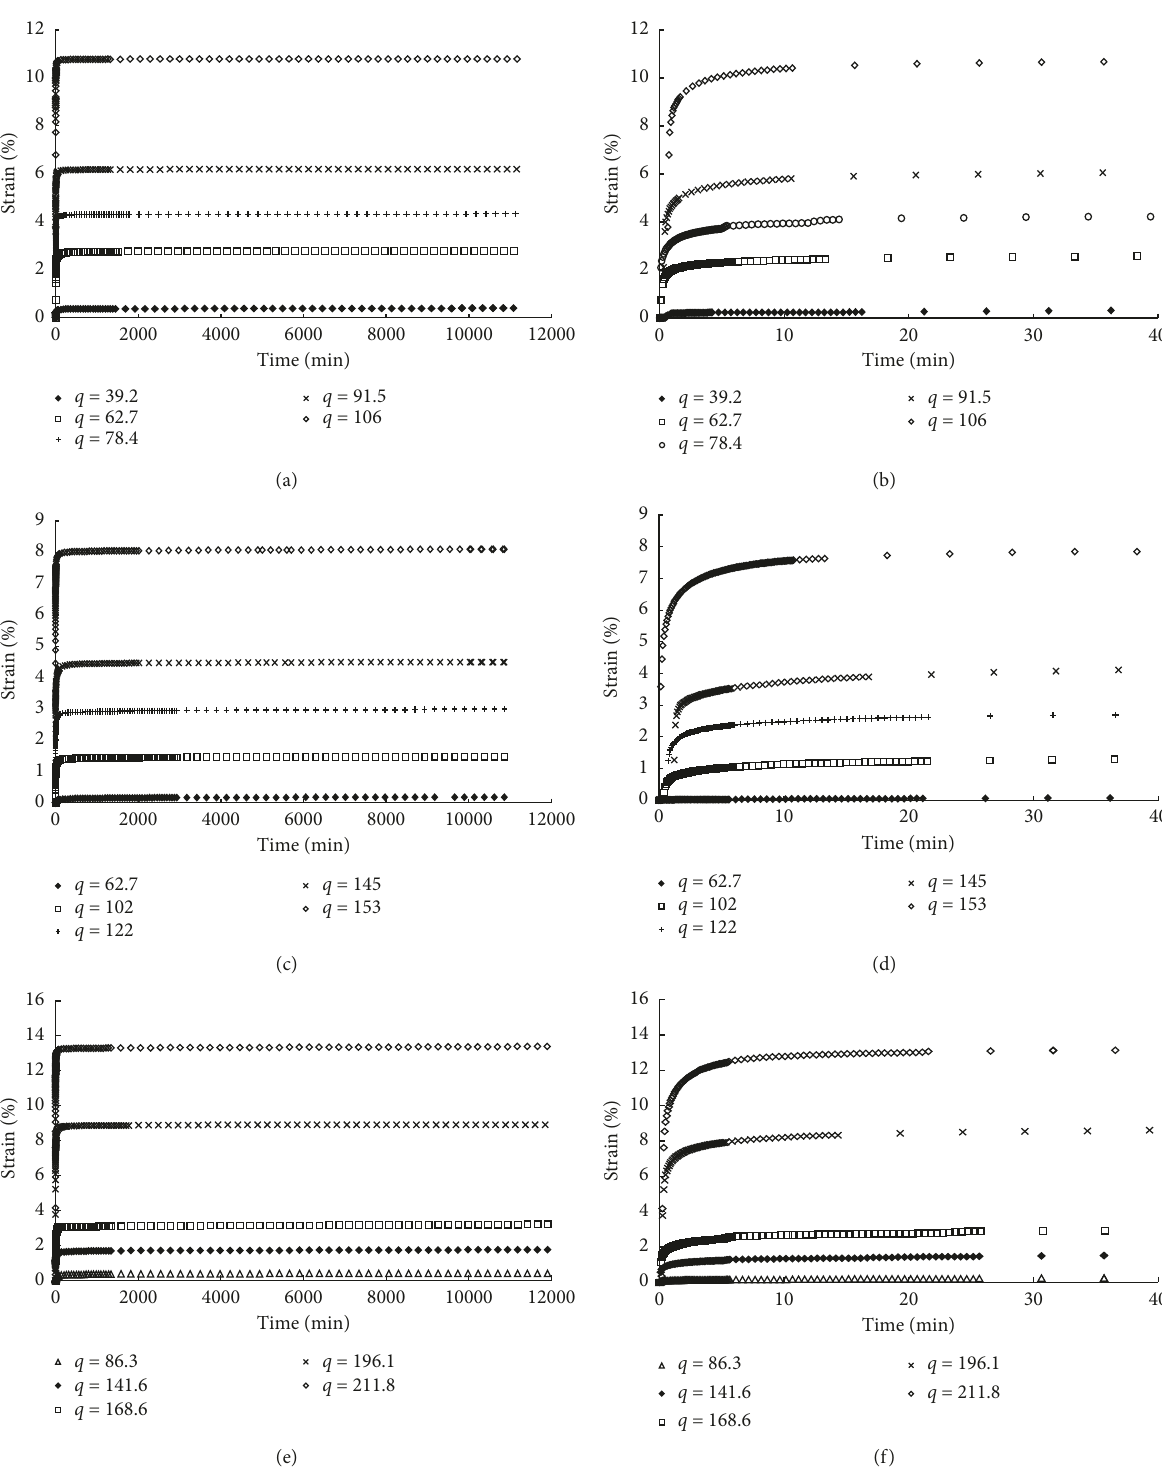
Figure 2: Creep curve under different confining pressures: (a) 100kPa; (b) 100kPa (first 40min); (c) 200kPa; (d) 200kPa (first 40min); (e) 300kPa; (f) 300 kPa (first